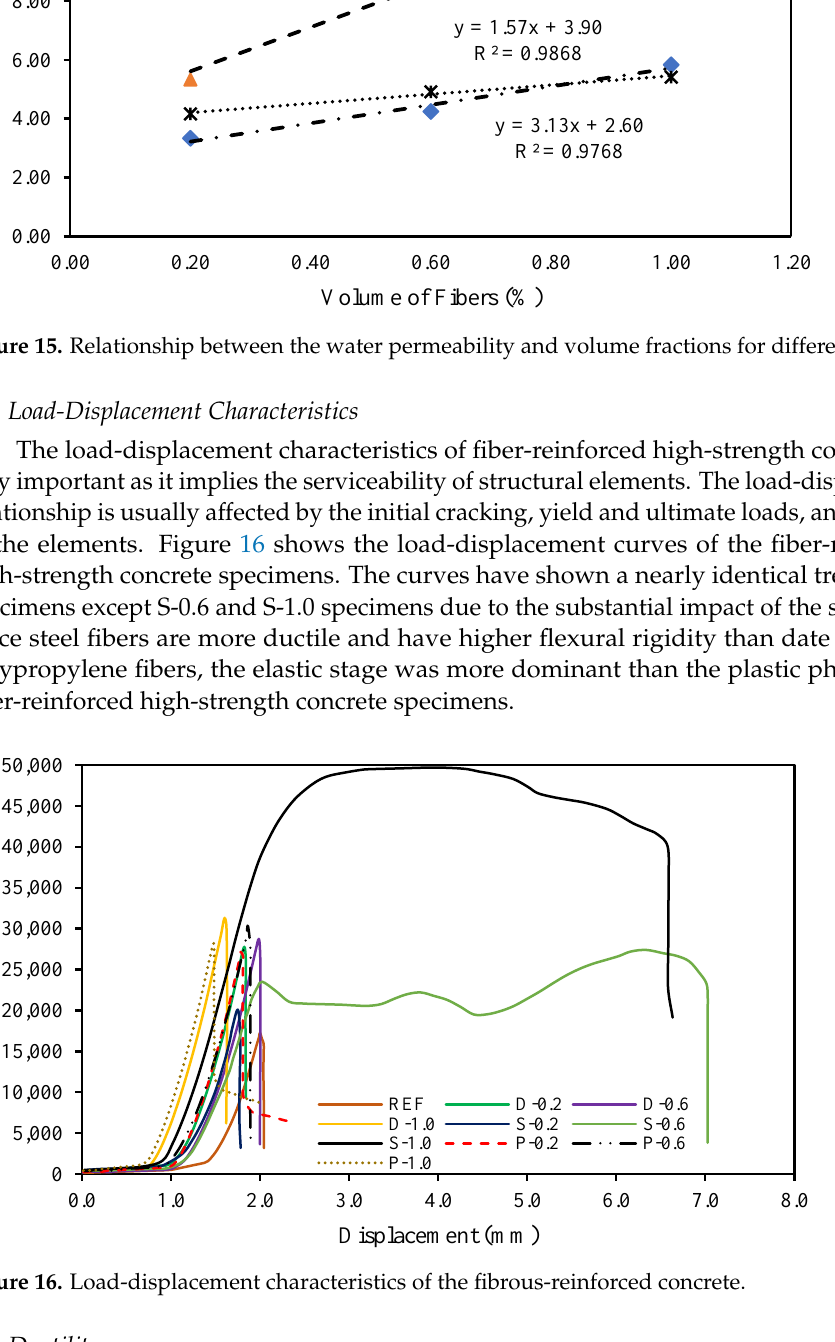
Figure 16. Load-displacement characteristics of the fibrous-reinforced concrete.